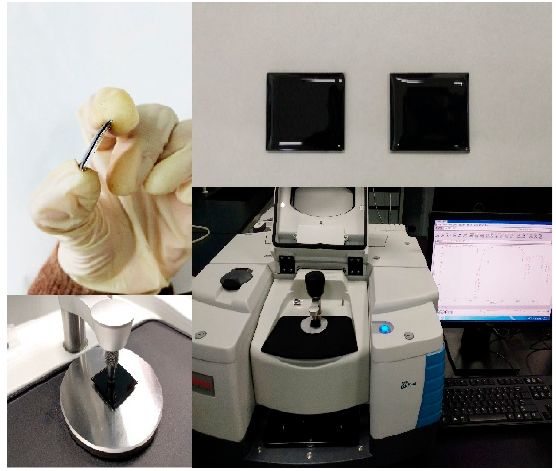
Figure 2. Infrared spectrum acquisition.